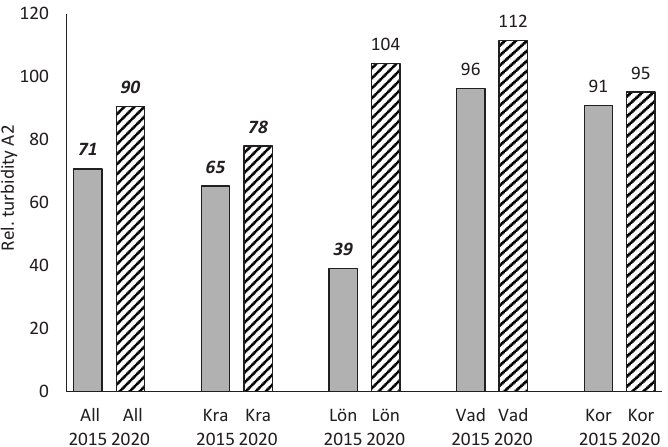
Fig. 5. Relative turbidity as a mean of the three structure liming treatments SL0.5–SL2 (applying 4, 8 and 16 t ha -1 structure lime, respectively), compared with the value in the unlimed control (SL0), where SL0 = 100. Results from the second rainfall simulation on 2–5 mm aggregates of tilled soil collected one year (2015) and six years (2020) after structure liming. Results for all trials (All) and for the individual sites: Krageholm (Kra), Lönhult (Lön), Vadensjö (Vad) and Kornheddinge (Kor). Values in bold italics indicate a significant difference compared with the unlimed control.